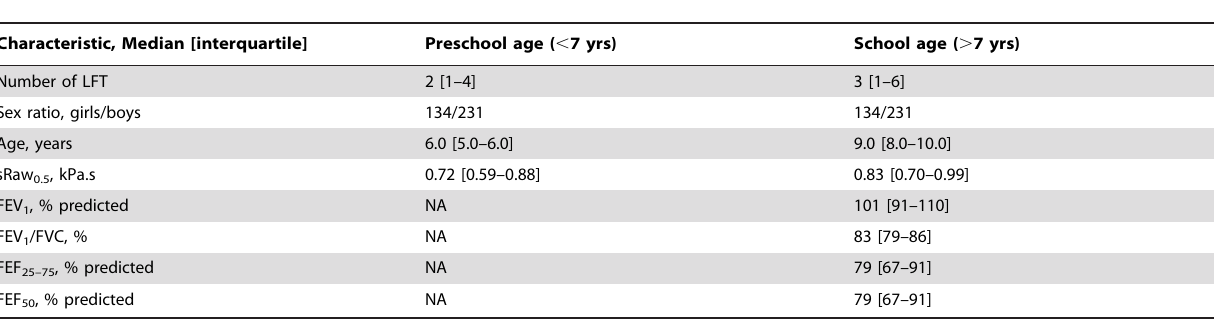
Table 3. Clinical and functional characteristics of the asthmatic children included in the longitudinal part of the study.